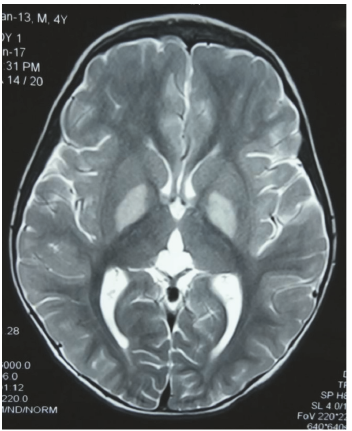
Figure 1: The MRI brain in the child with MUT-related MMA showing predominant frontoparietal abnormalities in form of encephalomalacia and